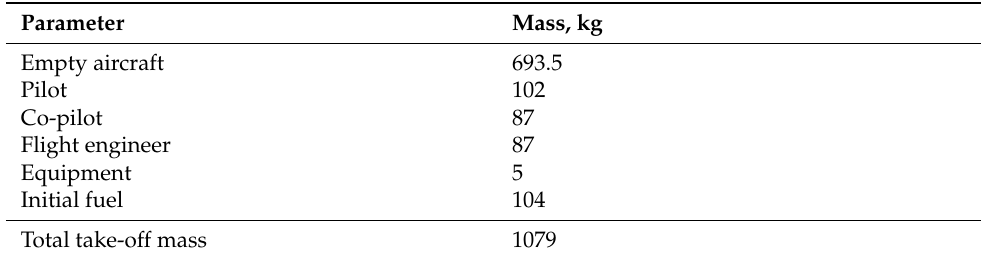
Table 1. Mass characteristics of the Cessna 172N aircraft.